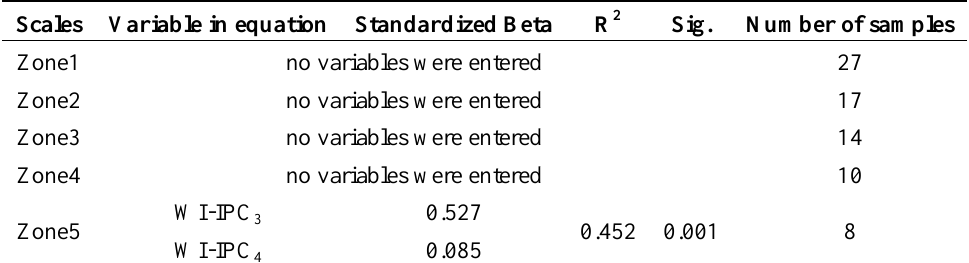
Table 10. Multiple regression model of COD